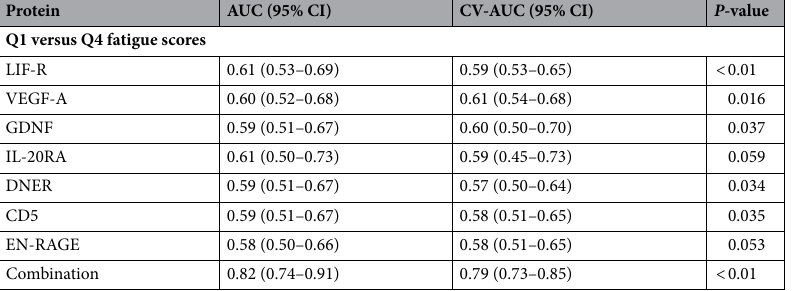
Table 3. Receiver operating characteristics (ROC) analysis demonstrating the discriminative value of plasma proteins with regard to the presence of (severe) fatigue in patients with IBD, defined by the lowest (Q1) versus highest (Q4) quartile of fatigue scores. Data are presented as areas under the curve (AUC) and AUCs after cross-validation (CV-AUC) with corresponding 95% confidence intervals (CI) and P -values. AUC area under the curve, CV-AUC cross-validated area under the curve, CI confidence interval.